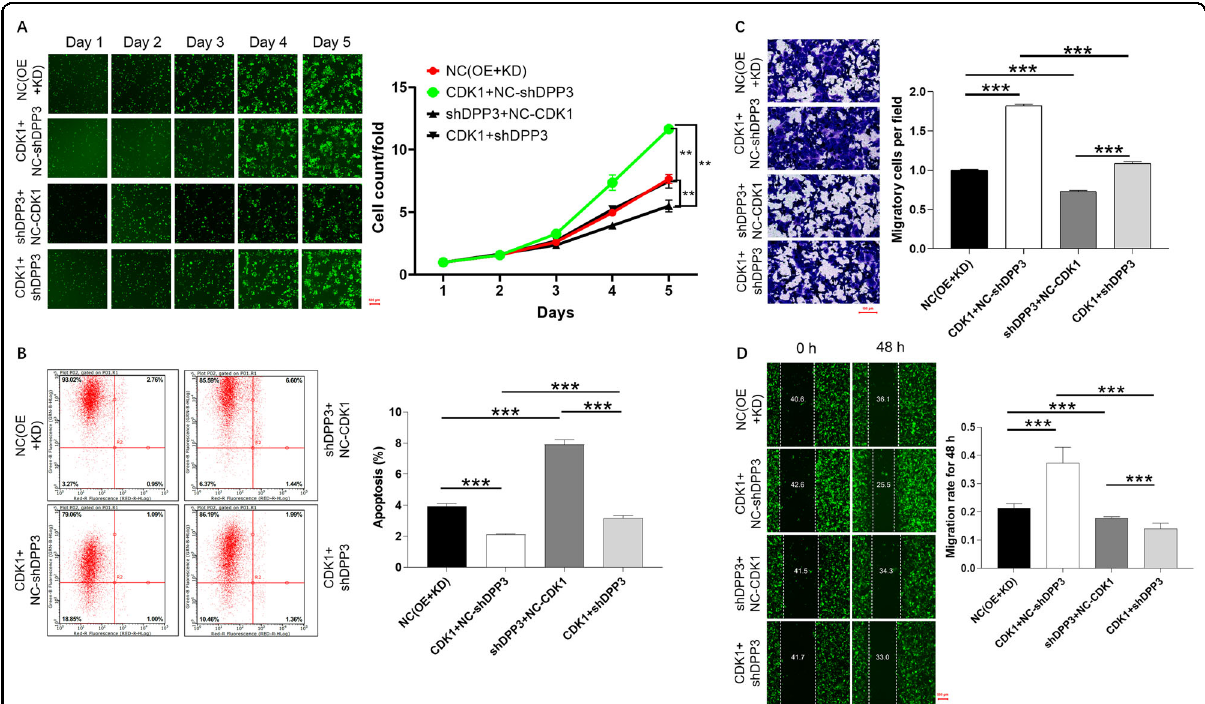
Fig. 6 Overexpression of CDK1 alleviates the inhibitory effects of DPP3 knockdown in CRC cells. Cell models were subjected to the detection of cell proliferation ( A ), cell apoptosis ( B ). The cell migration ability was accessed by wound-healing assay ( C ) and Transwell assay ( D ). The representative images were selected from at least three independent experiments. Data were shown as mean ± SD. * P < 0.05, ** P < 0.01, *** P <